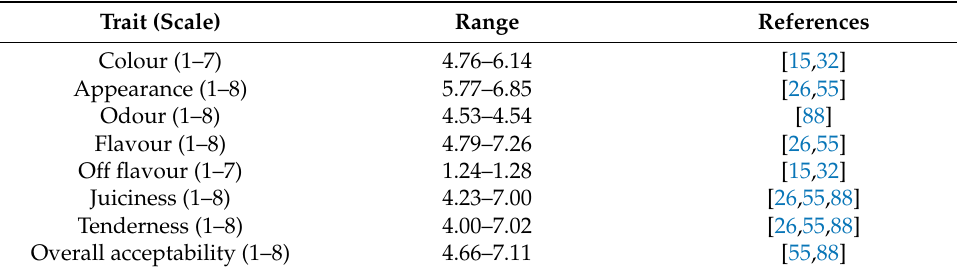
Table 8. Sensory traits of river buffalo